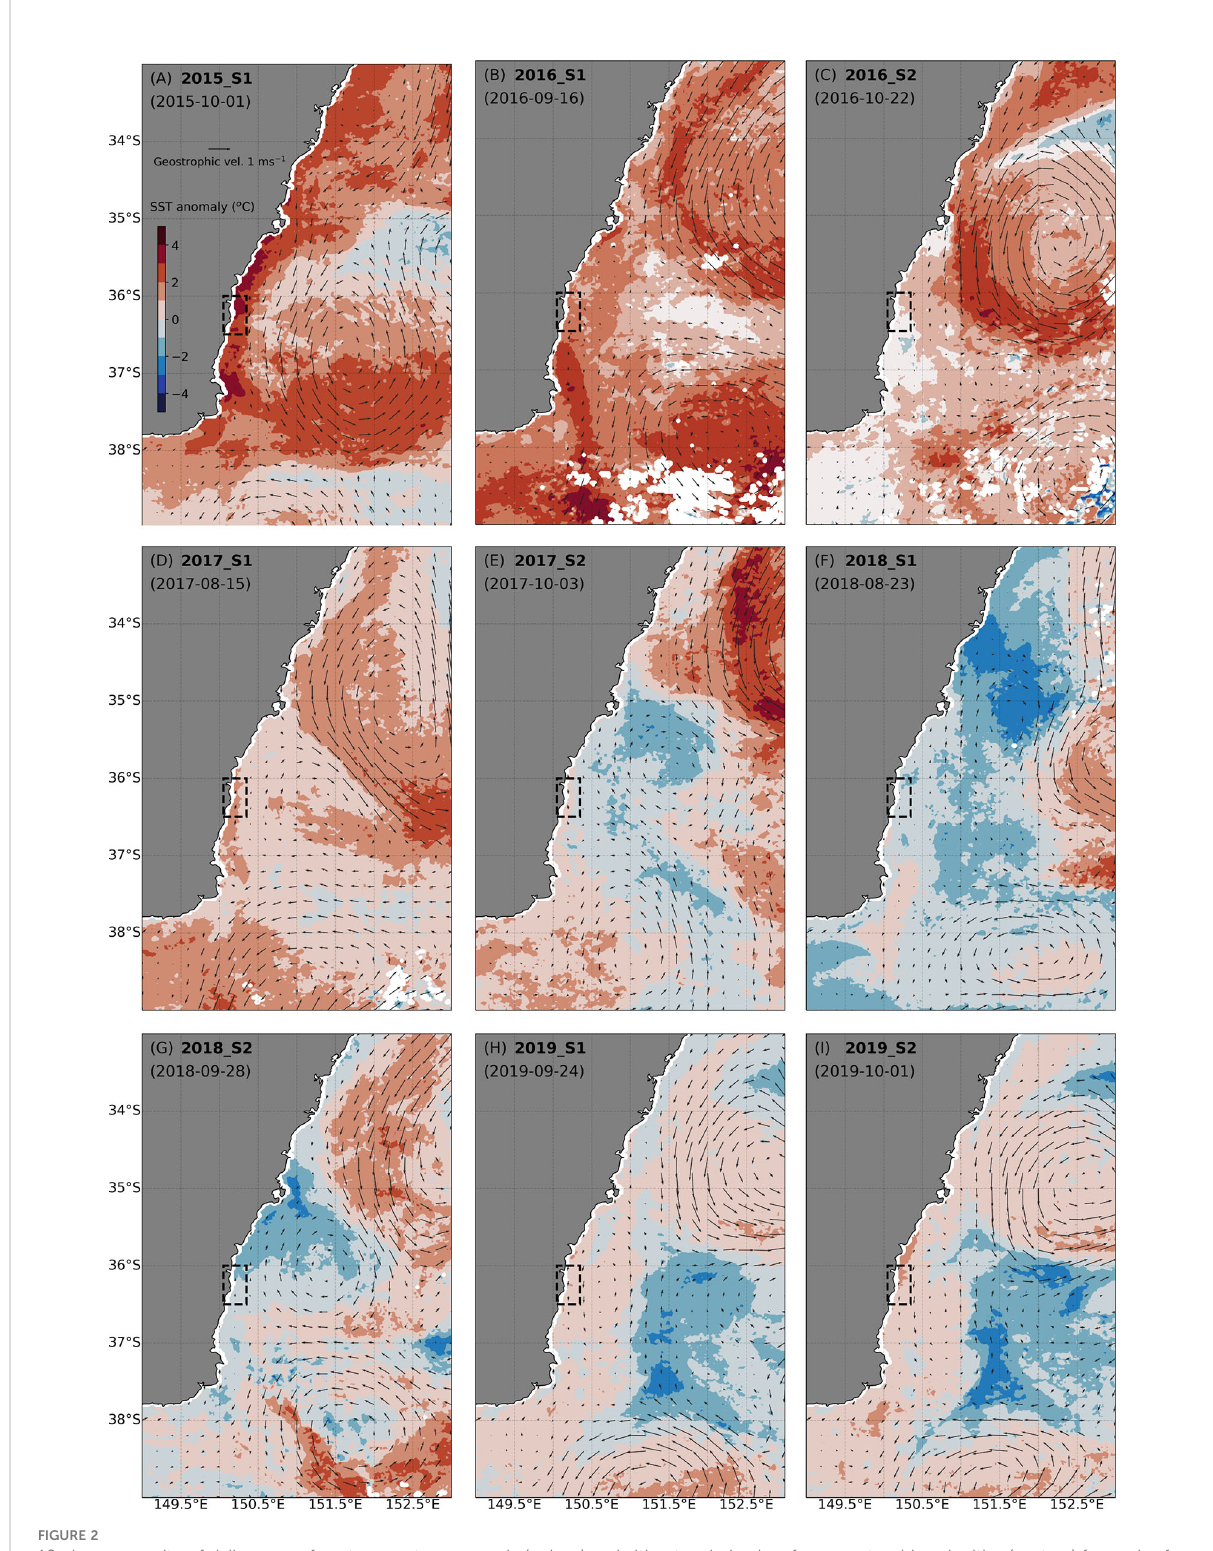
FIGURE 2 10-day composite of daily sea-surface temperature anomaly (colour) and altimetry-derived surface geostrophic velocities (vectors) for each of the survey periods (A – I) . The survey area is shown as a black rectangle. The displayed date is the fi rst day of the 10-day